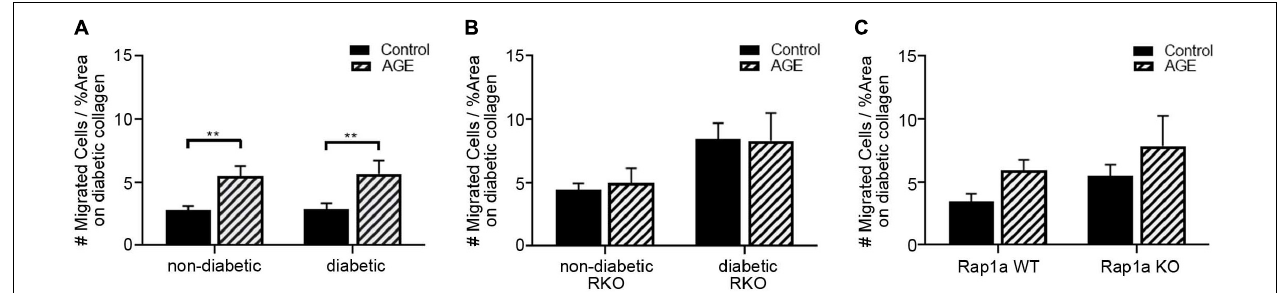
FIGURE 6 | Increased exogenous AGEs in diabetic collagen led to increased fibroblast migration. Cardiac fibroblasts from (A) non-diabetic and diabetic, (B) RAGE knockout, and (C) Rap1a mice were plated on diabetic collagen. Fibroblasts were either untreated (control) or treated with AGEs (0.5 mg/mL). Cell migration was normalized to percent scratch area with mean ± SEM being depicted on graph. Two-way ANOVA with Sidak’s post hoc test determined significance ( ** p < 0.01, n = 5–10).